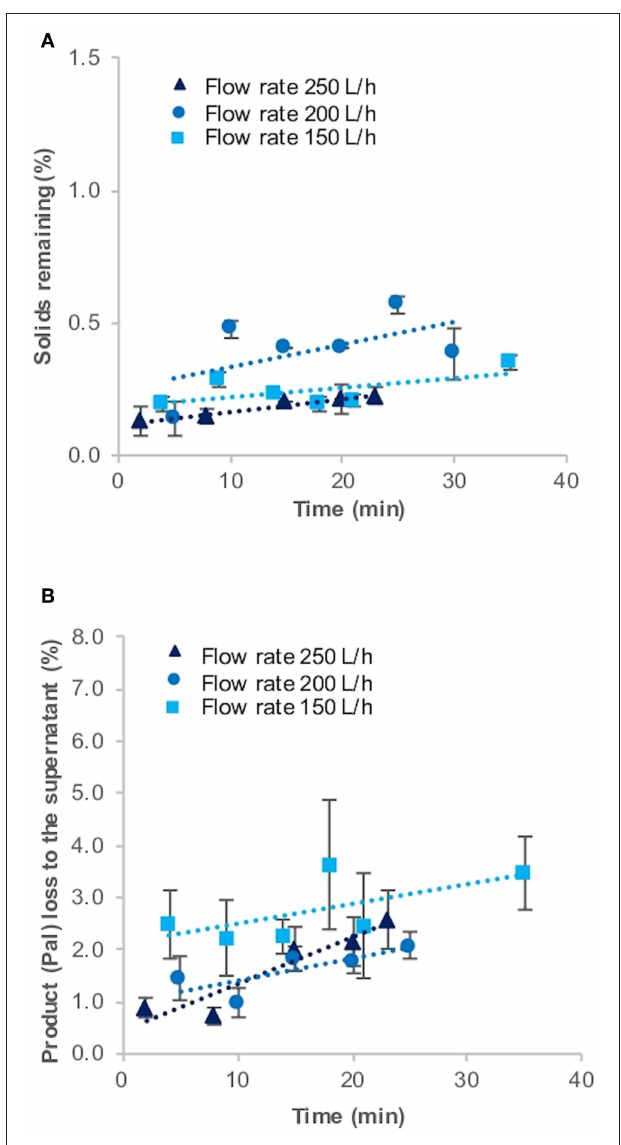
FIGURE 3 | Solids remaining (%) (A) and product loss (%) (B) to the supernatant during harvest of Chlamydomonas reinhardtii TN72_pal by continuous-flow disc-stack centrifugation. Three 100L pilot-scale cultures were harvested in a GEA Westfalia CSA-1 at flow rates of 150L.h − 1 (Q/ 6 65 × 10 − 9 m.s − 1 ), 200L.h − 1 (Q/ 6 87 × 10 − 9 m.s − 1 ), and 250L.h − 1 [(Q/ 6 109